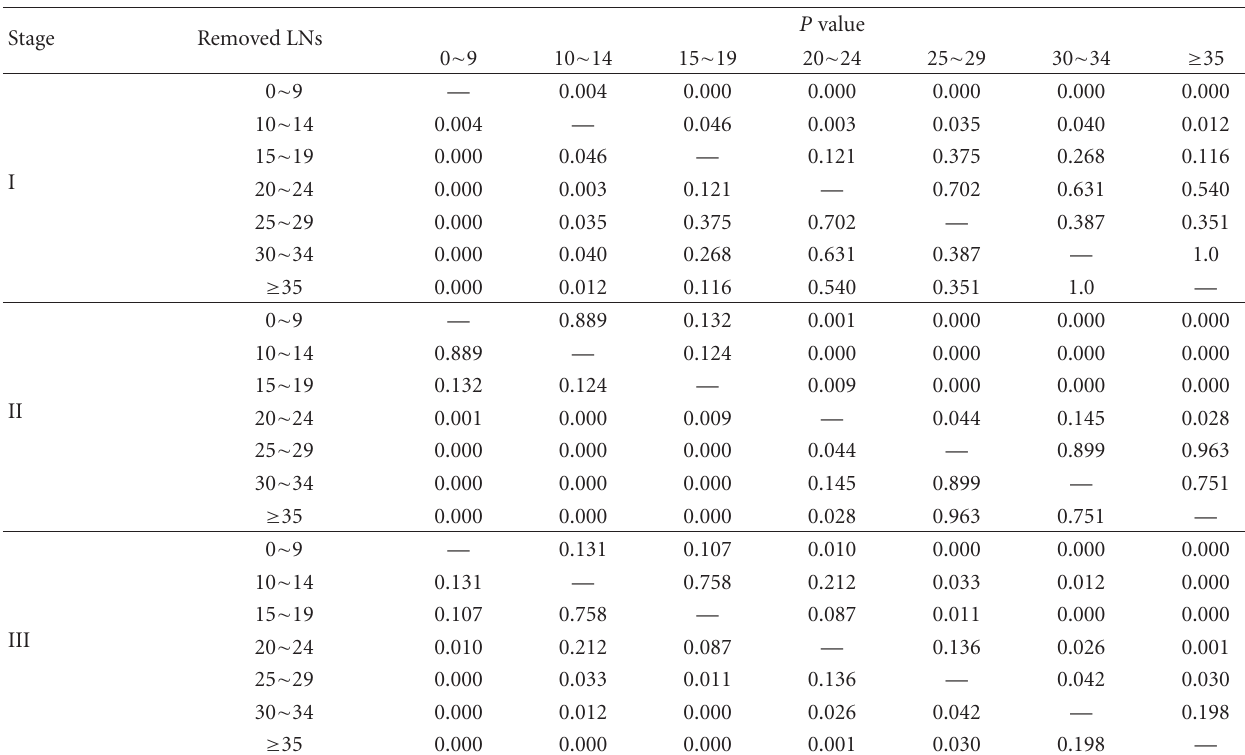
Table 6: Pairwise comparisons of overall survival of patients with di ff erent number of dissected LNs after surgery by Kaplan-Meier